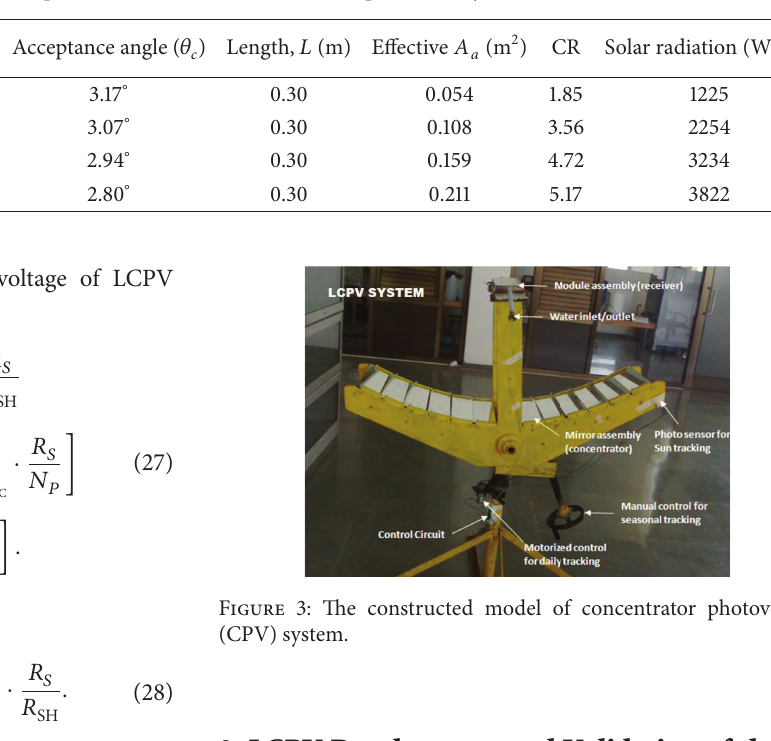
Table 1: Simulation parameters for desired CR in developed LCPV system.